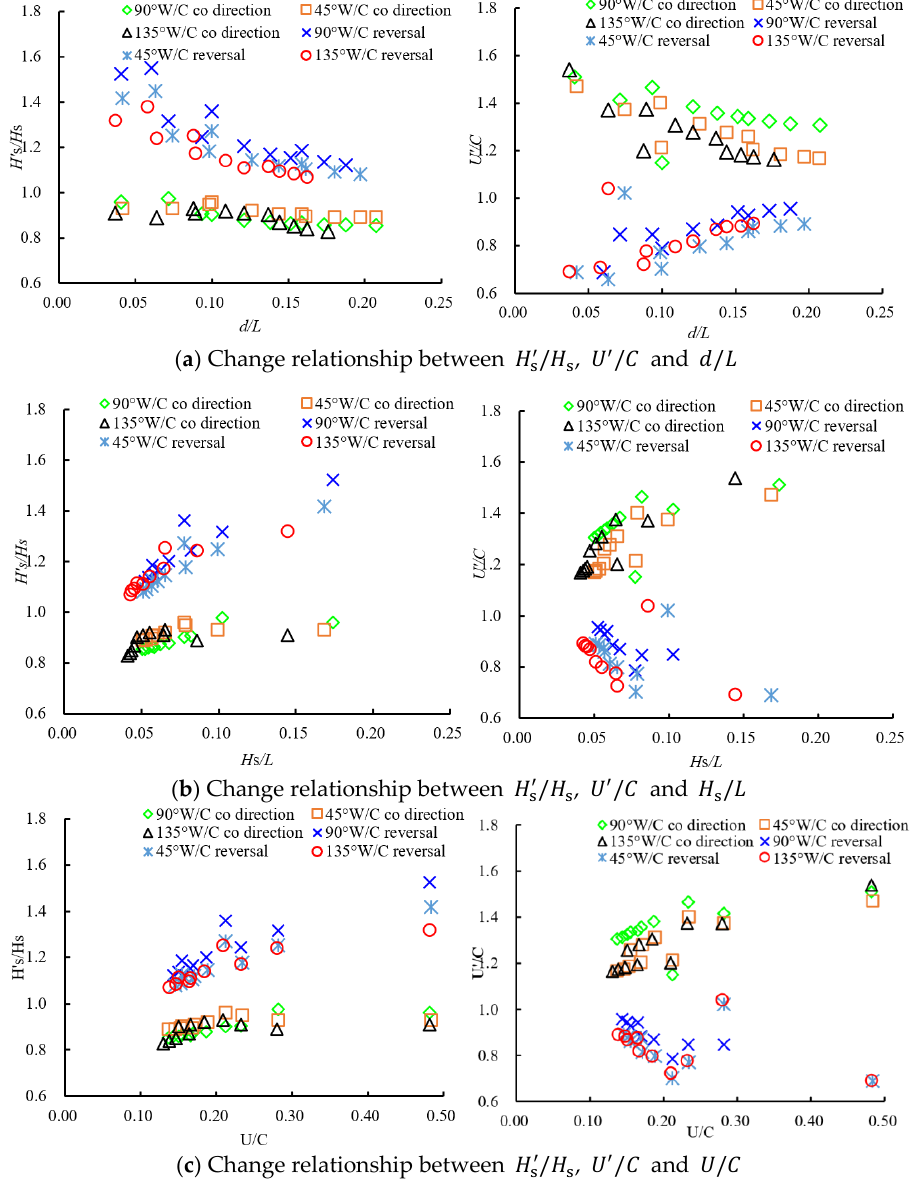
(cid:48) / C and d / L , H s / L , U / C s / H s , U